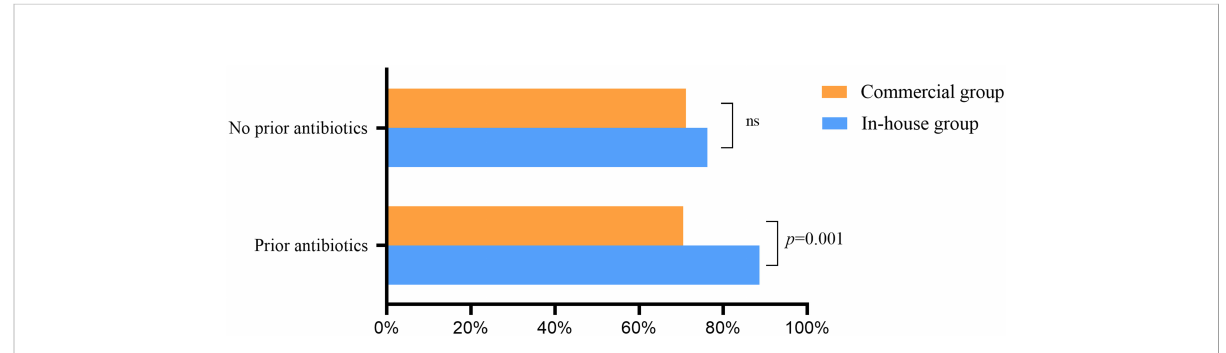
FIGURE 6 Effect of previous antibiotic exposure on the positivity rate of metagenomic next-generation sequencing (mNGS) ns, no signi fi cance.